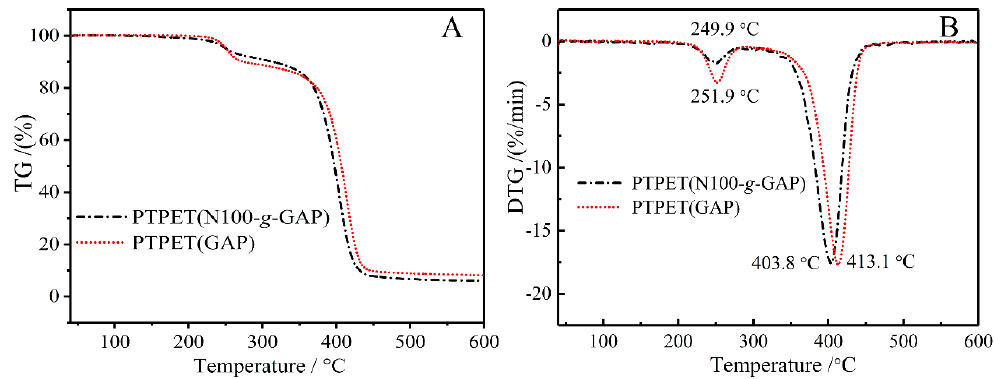
Figure 2. TG ( A ) and DTG ( B ) curves of N100- g -GAP and GAP ( Mn = 4000 g/mol).